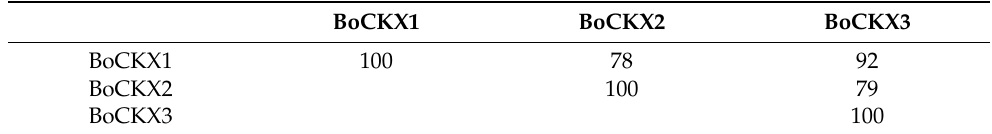
Table 1. Amino acids identities (%) among the coding regions of the BoCKX1, BoCKX2, and BoCKX3 proteins.